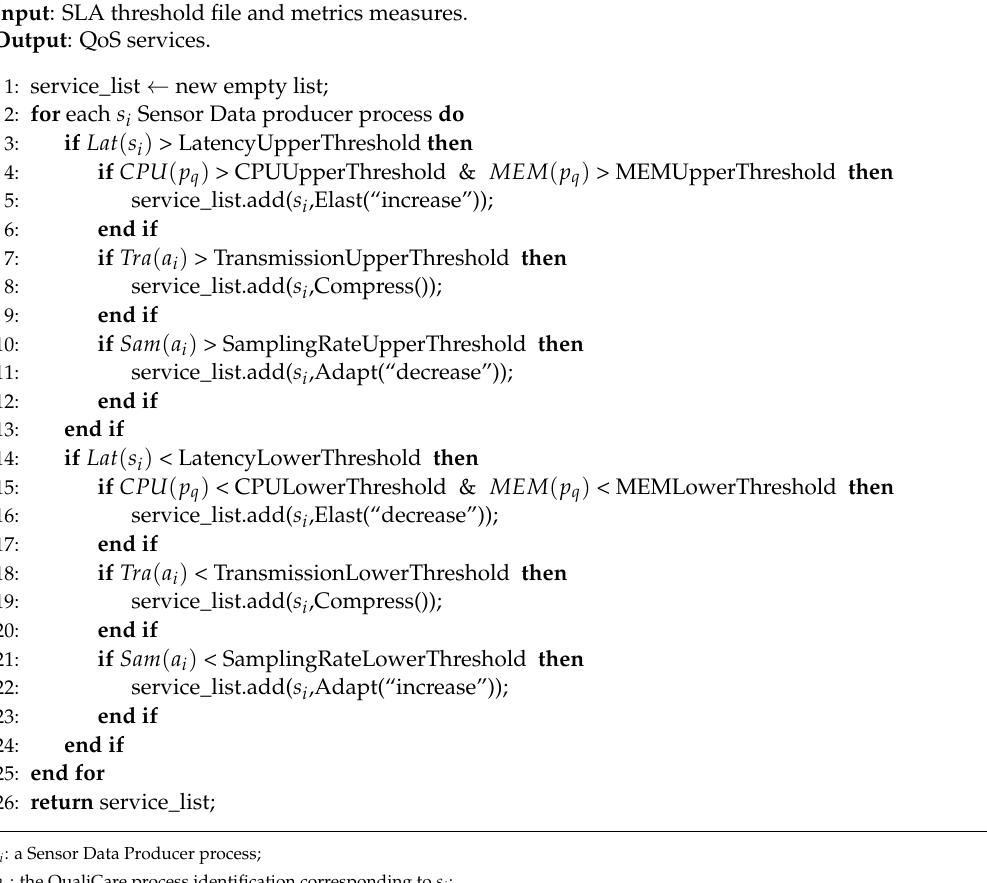
Algorithm 2 Sensor Orchestration Exectution